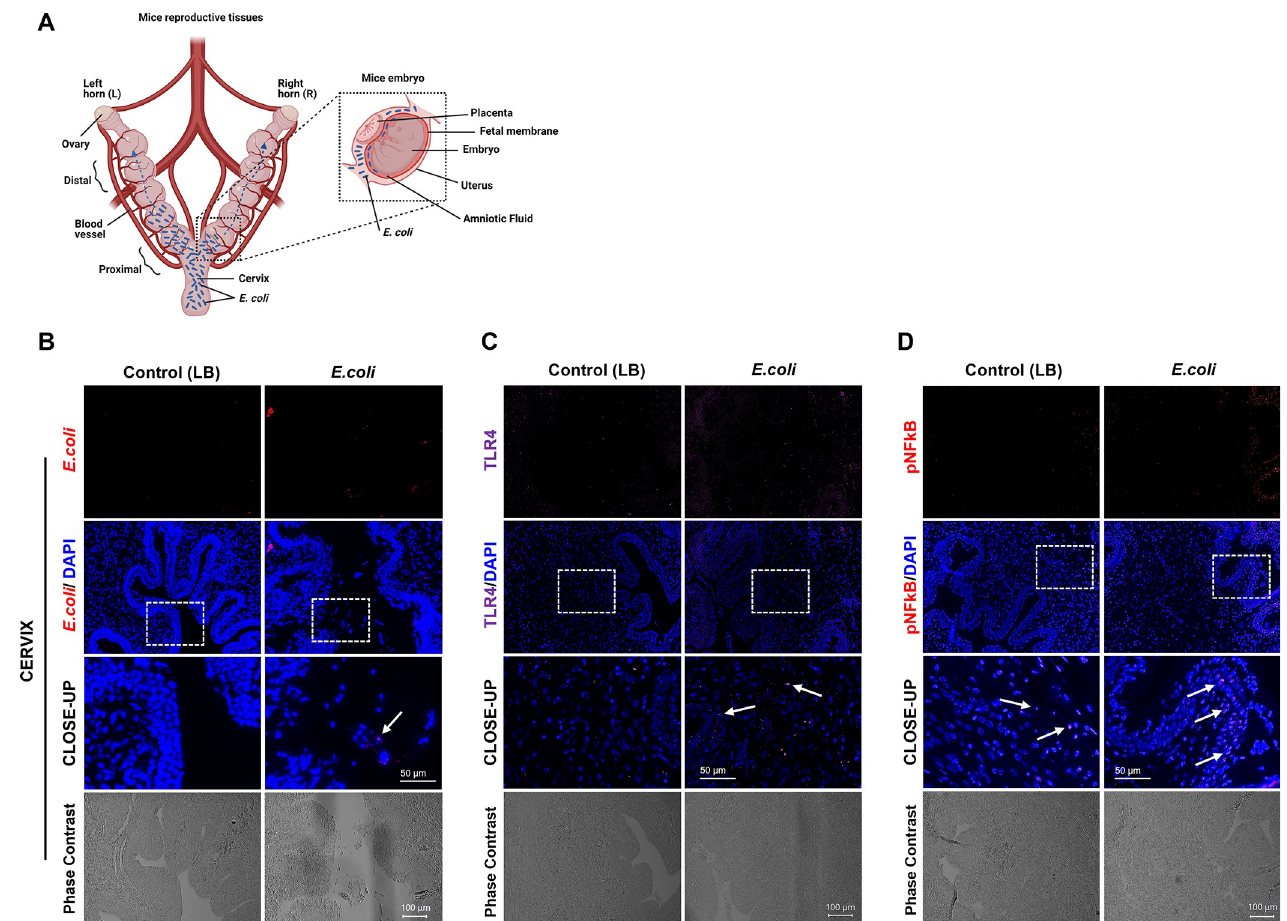
Fig 4. E . coli induced inflammation in mouse reproductive tissues. ( A ) Schematic illustration of mouse reproductive tissues and close-up display of an embryo in the uterine cavity. Reprinted from biorender under a CC BY license, with permission from biorender, original copyright. ( B-D, N = 3). Immunohistochemical analysis of cervix collected 6 hr after vaginal administration of 10 11 CFU of E . coli . E . coli detected in the cervical sections ( B , see white arrow , E . coli positive staining) . Infected cervix shows higher expression of TLR-4 ( C) and P-NFkB (D ) compared to control cervix (Scale bar, 100 μ m). The close-up displays the enlarged tissue area marked by white boxes (Scale bar, 50 μ m).